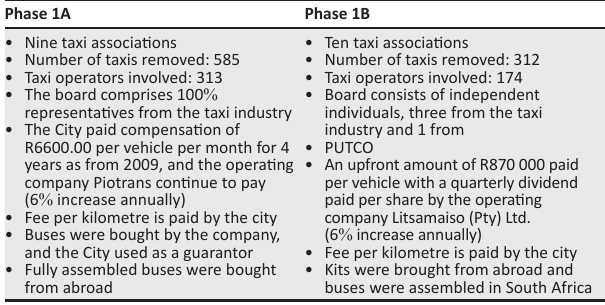
TABLE 1: Summary of salient features of Phase 1A and Phase